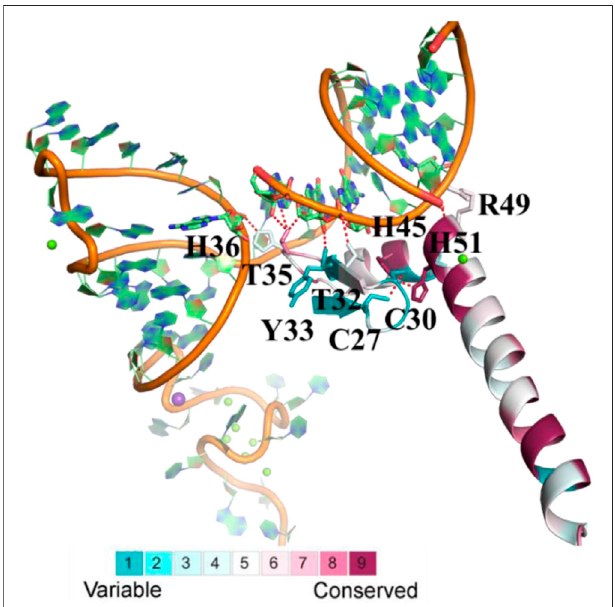
FIGURE 2 | The evolutionary conservation analysis of amino acid positions in animal U1Cs. The crystal structure of human U1C with its target RNA is shown. The ribbon representation is colored according to ConSurf Grade (1-blue to 9-purple) by using all identi fi ed protein sequences of animalU1Cs.C27,C30,H36,H45,H51,R49,T32,T35and Y33areresidues of human U1C. C, H, R, T and Y are symbol of cysteine, histidine, arginine, threonine and tyrosine,